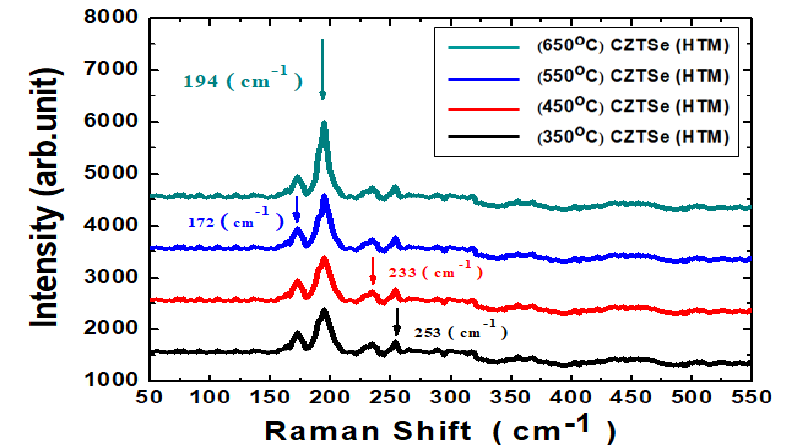
Figure 5. The compositional dependence of Raman spectra of the Cu 2 ZnSnSe 4 HTM nano-films. The arrows point towards the corresponding wave numbers.